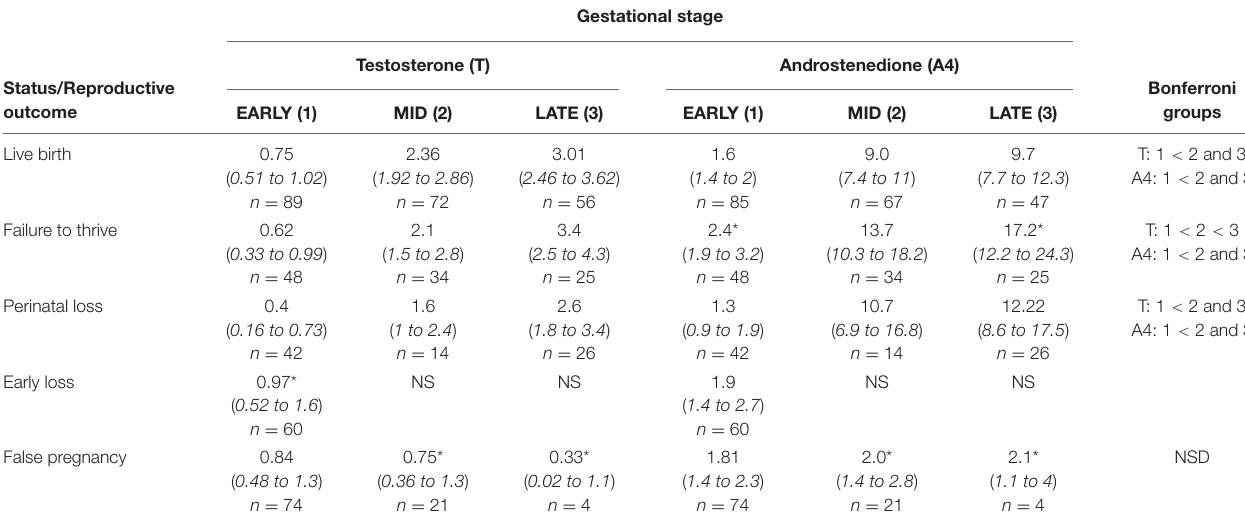
TABLE 3 | Marginal mean ( 95% CI ) testosterone and androstenedione concentrations (ng/ml) during each stage of normal (live birth) and abnormal bottlenose dolphin pregnancies.